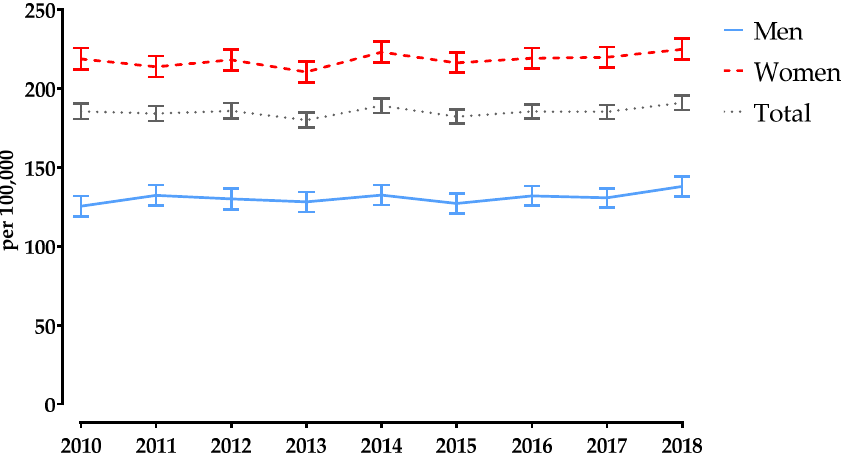
Figure 3. Annual age-standardised incidence rates of pelvic fractures in Austria, stratified by sex, for 2010–2018. Bars represent 95% confidence intervals.